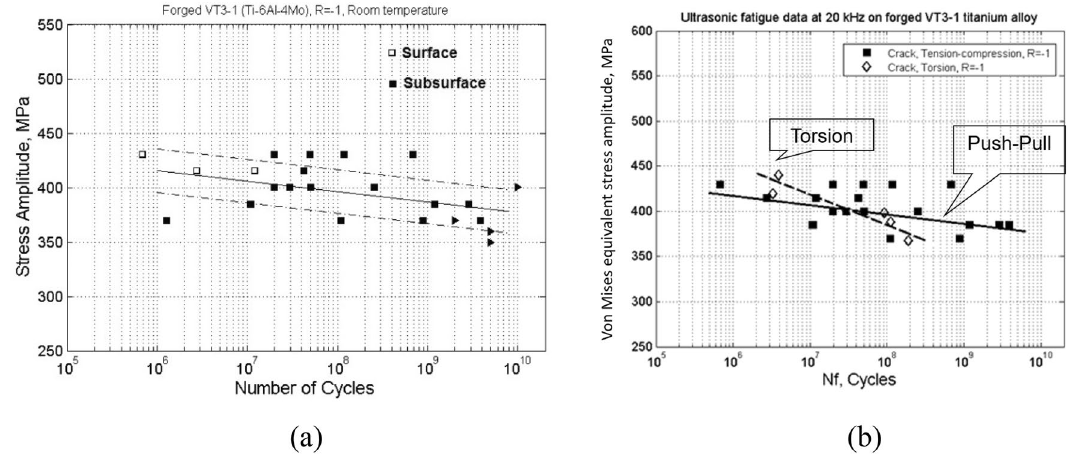
Fig. 5 Results of fatigue tests of titanium alloy